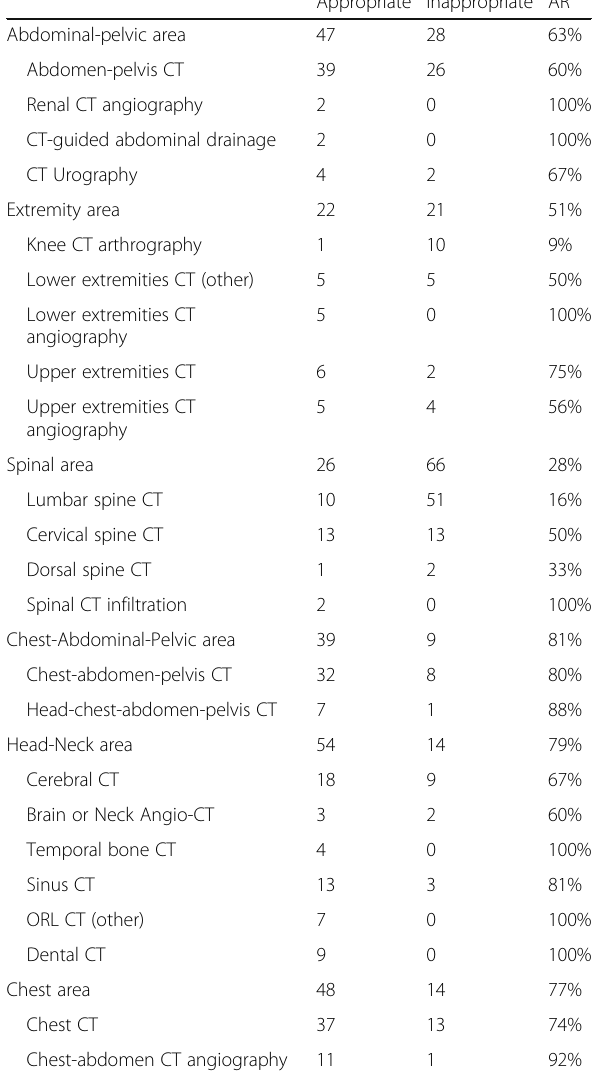
Table 2 Number of appropriate and inappropriate requests and appropriateness rates (AR) for CT according to the type of CT